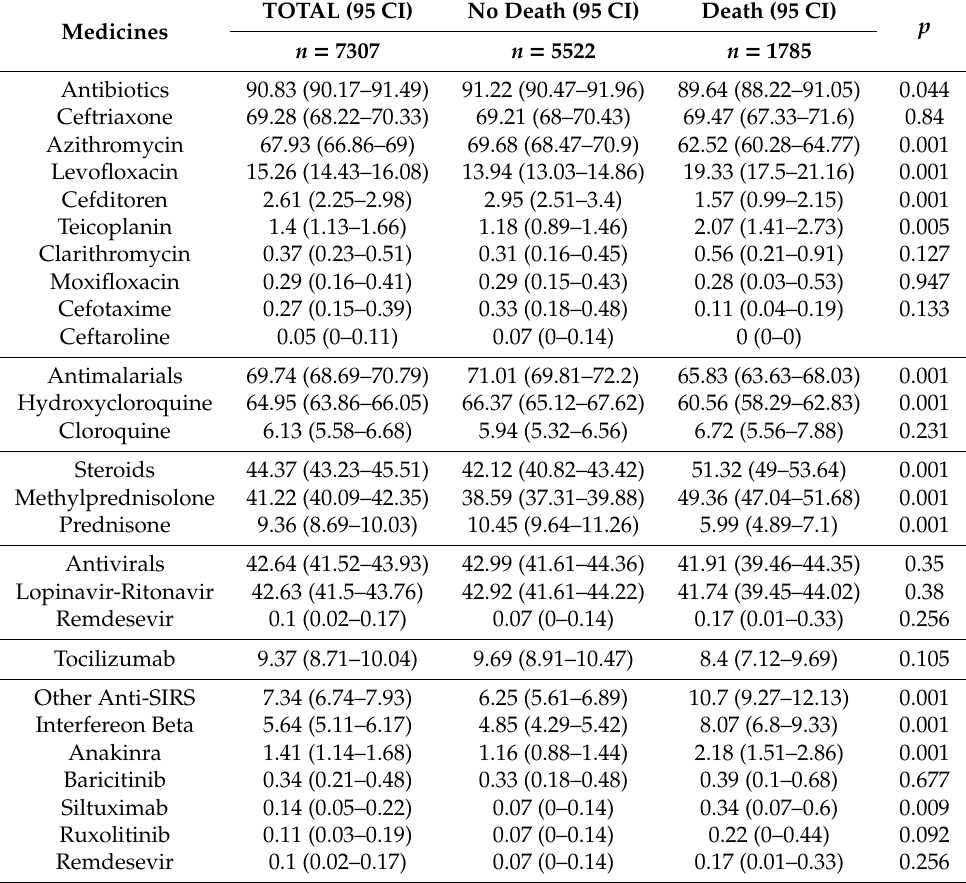
Table 3. Pharmacological treatment in hospitalized COVID-19 patients in Castile and Leon (Spain) during the first wave (1 March to 31 May 2020).